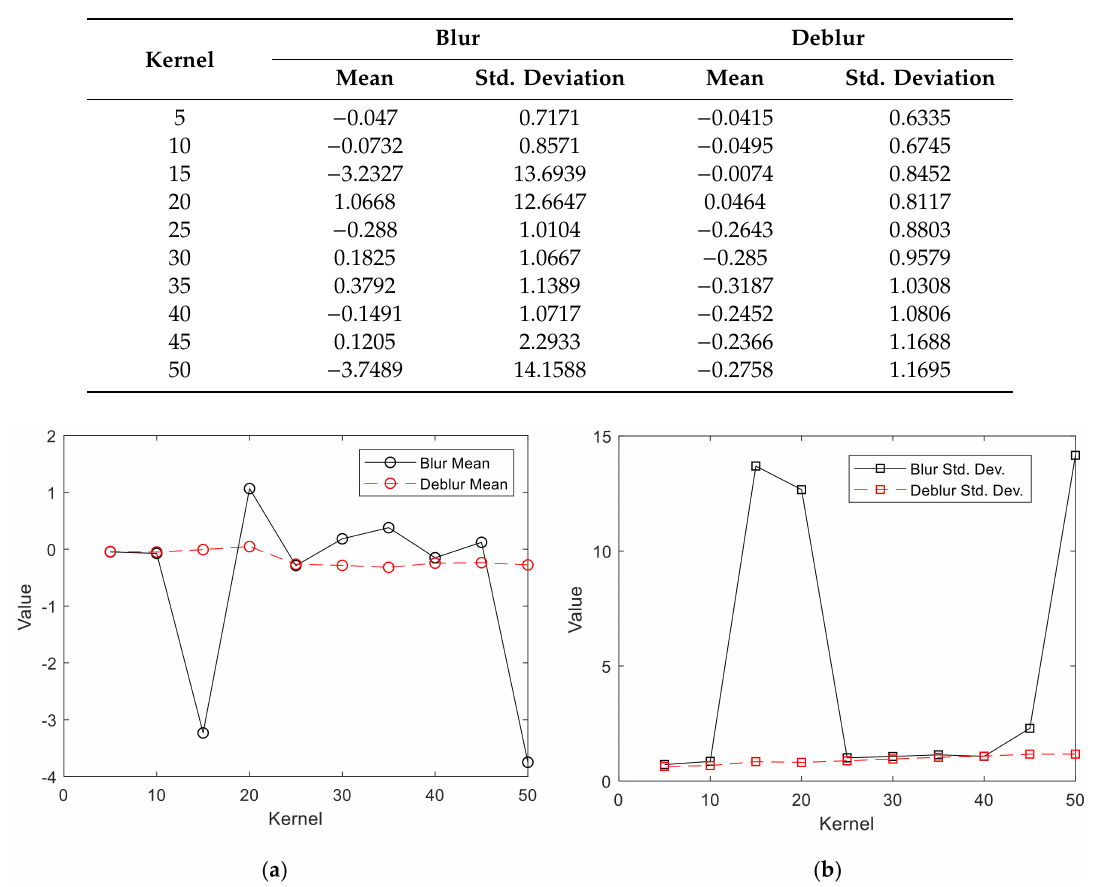
Table 9. Calculated M3C2 distances.